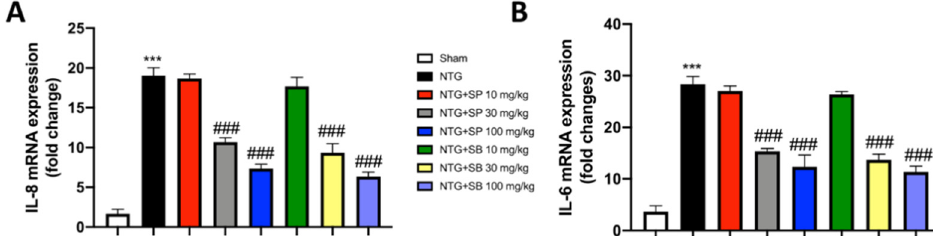
Figure 8. SCFA treatments decrease interleukin mRNA expression. NTG-injected mice show a significant increase in Il-6 and IL-8 mRNA expression. SCFAs of 30 mg/kg and 100 mg/kg decrease both interleukins expression following NTG administration (( A , B ), respectively). Data are representative of at least three independent experiments; one-way ANOVA test. *** p < 0.001 vs. sham; ### p < 0.001 vs. NTG. N = 10 mice/group for each technique.